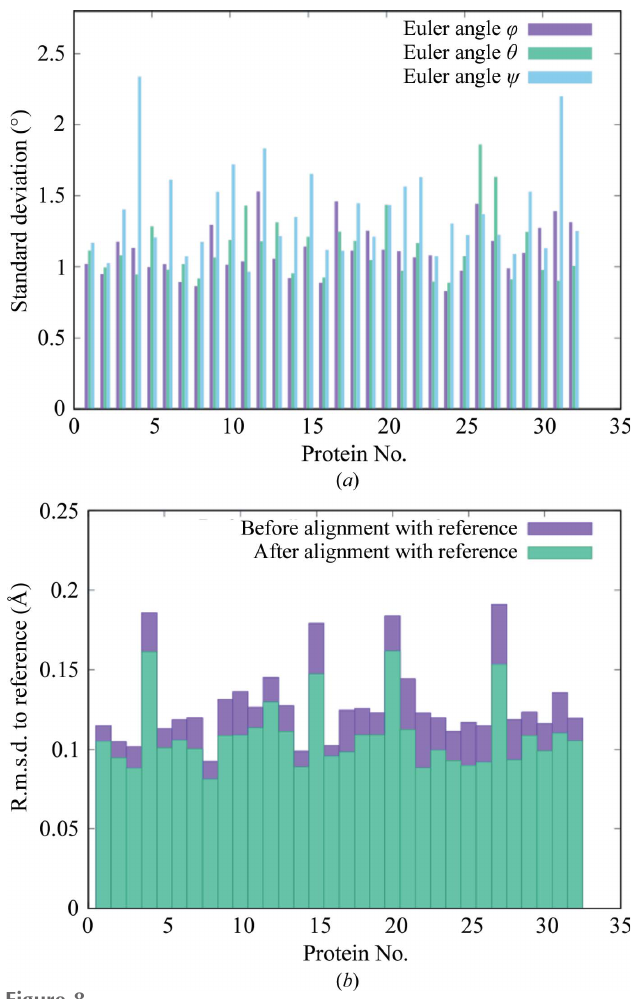
Figure 8 Analysis of the MD trajectory in terms of rigid-body motions of whole proteins. ( a ) Standard deviations of Euler angles that optimally align protein snapshots with the reference structure. ( b ) R.m.s.d.s of coordinates computed before and after aligning protein snapshots with the reference